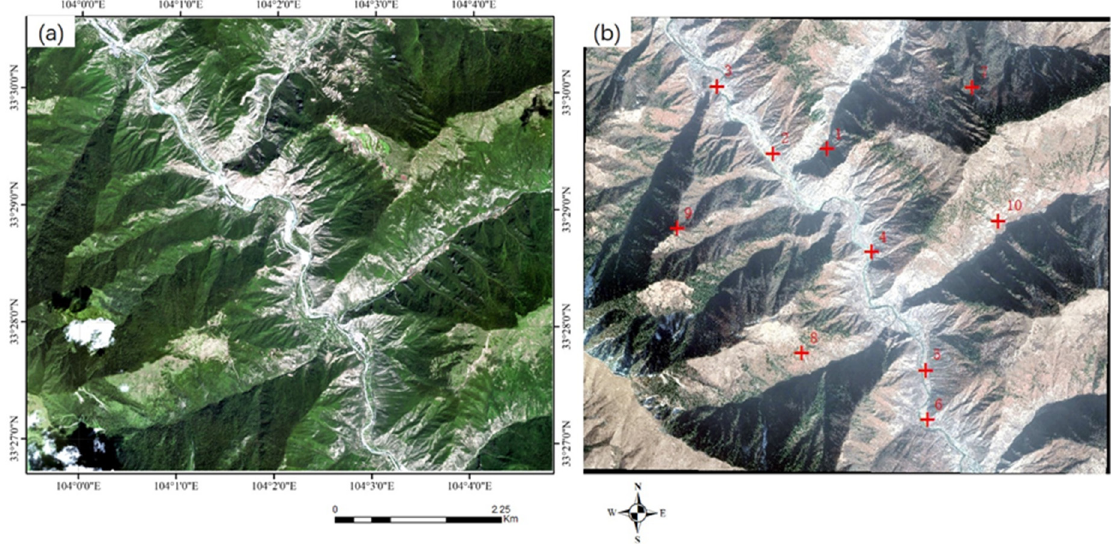
Figure 8. HR multispectral images with disaster P-E. ( a ) GF-2 image (input image), ( b ) GE image (reference image). Points in red are verification points.